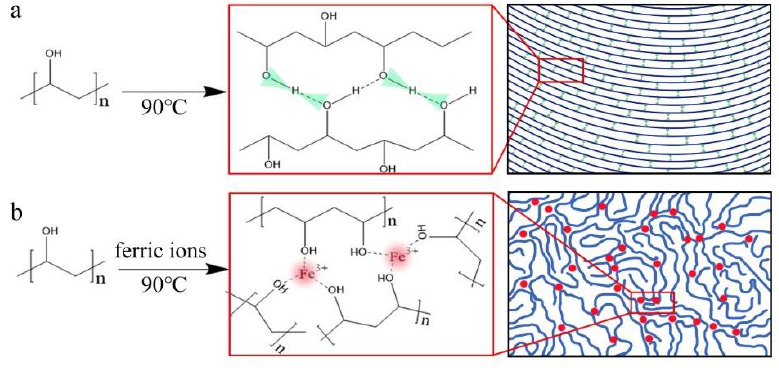
Figure 4. Schematic illustration for the structure formation of ( a ) pure PVA and ( b ) ferric ions modified PVA.